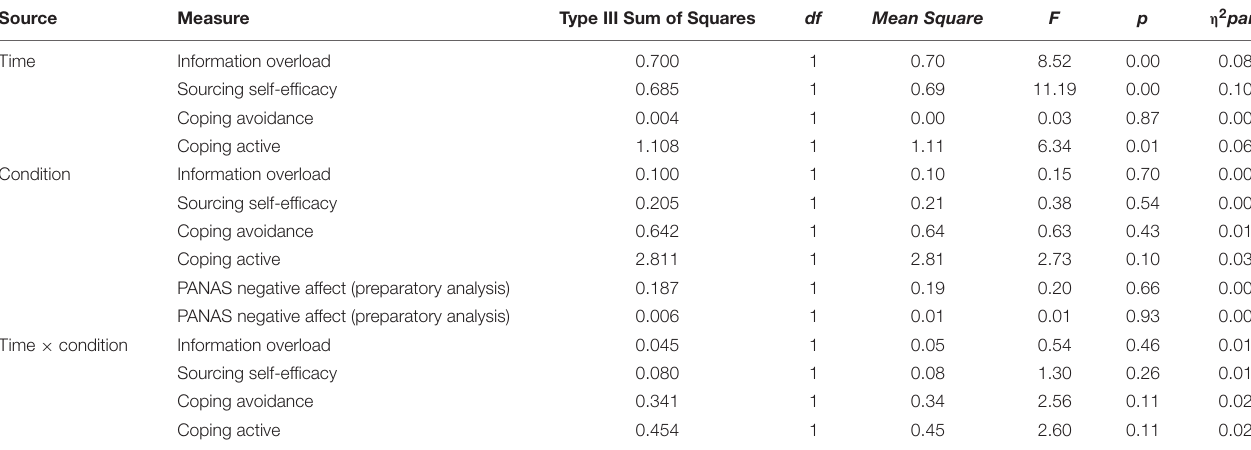
TABLE 4 | MANOVA to test for differences between the experimental conditions and within subjects (time) regarding the scales.